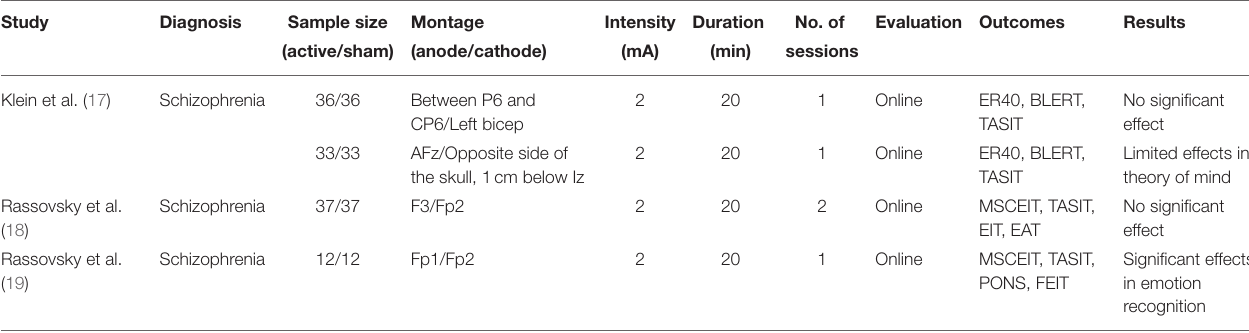
TABLE 1 | Transcranial direct current stimulation and social cognition impairments in schizophrenia [adapted from Yamada et al. (13)]. Study Diagnosis